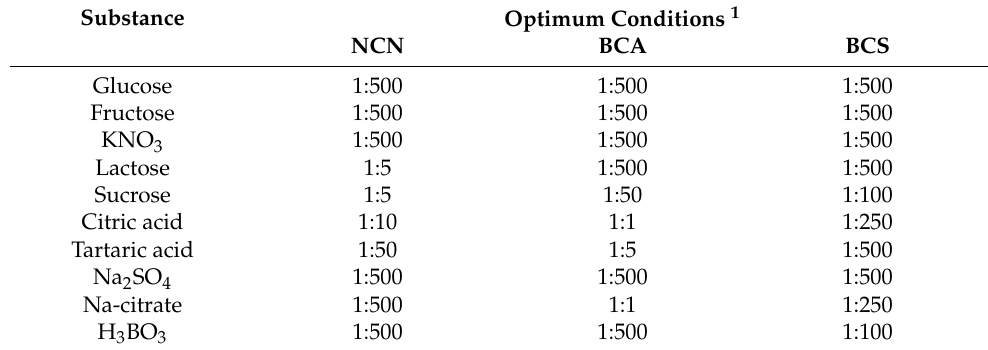
Table 3. The effect of possible interfering substances for the developed method.